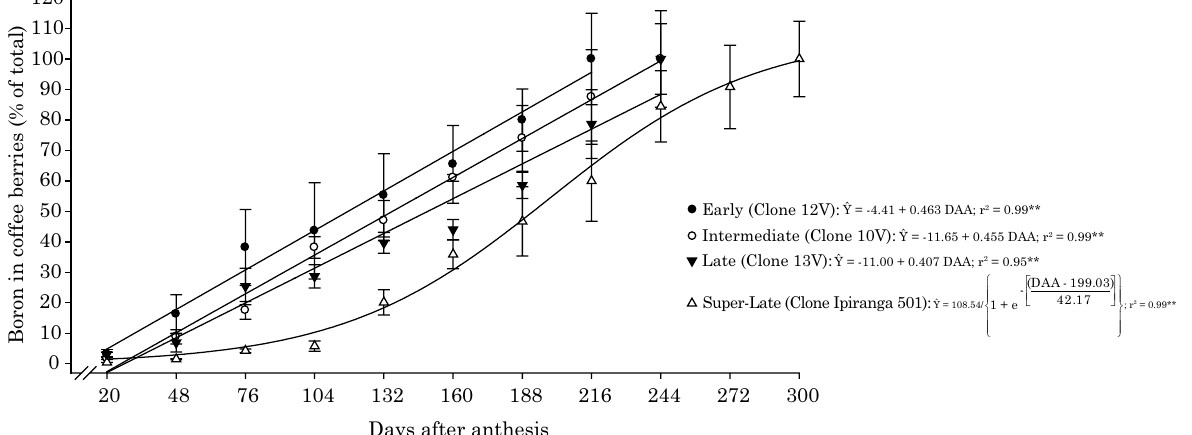
figure 5. Boron accumulation in berries (as a percentage of total accumulation) of four genotypes (clones) of ‘conilon’ coffee, from anthesis to fruit maturation. Bars represent standard deviation of the mean. **: significant at 1